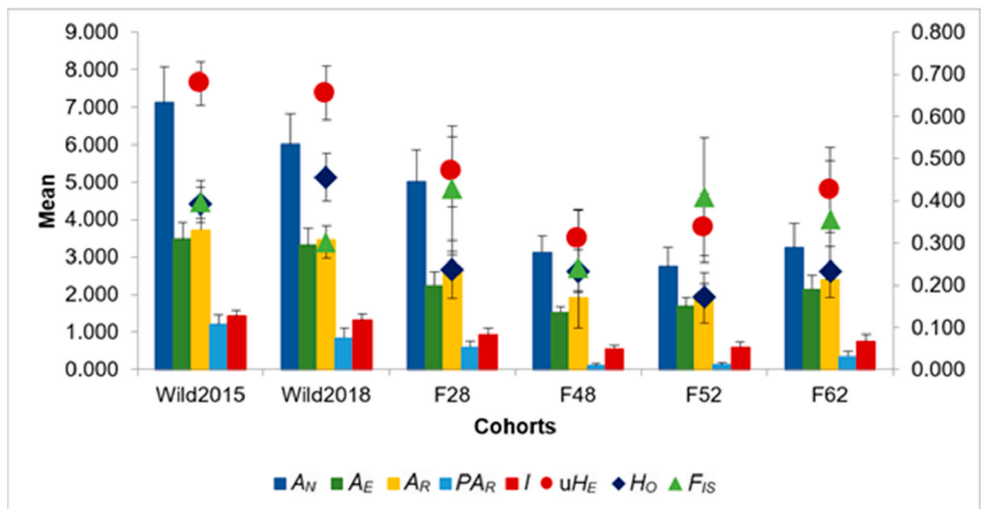
Figure 1. Summary of genetic diversity statistics across the six sampling populations. A N : number of alleles; A E : effective number of alleles; A R : allelic richness; PA R : private allelic richness; I : Shannon’s Index; u H E : unbiased expected heterozy- gosity; H O : observed heterozygosity; F IS : inbreeding coefficient. Error bars represent standard error (comprehensive results are given in Table